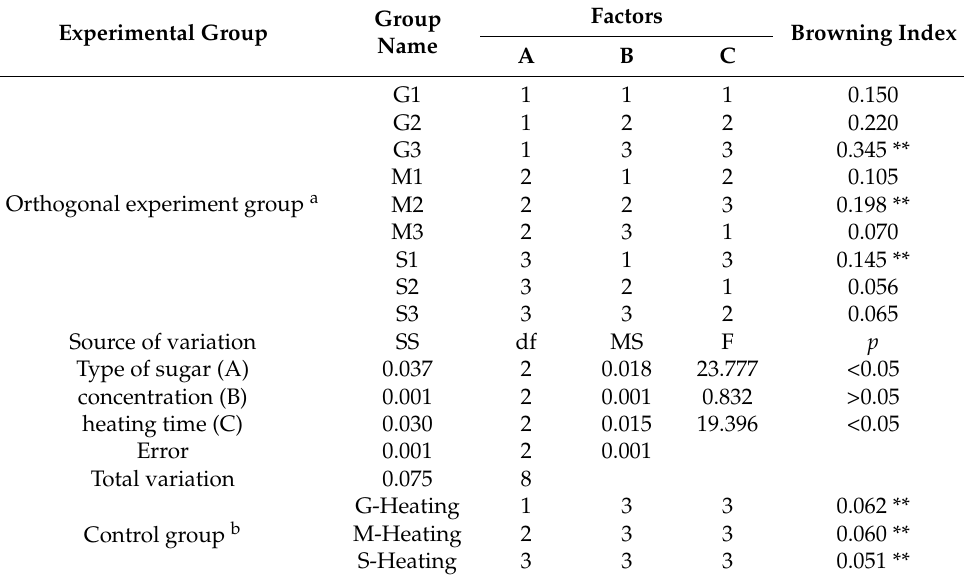
Table 1. Orthogonal experiments of the microwave-assisted Maillard